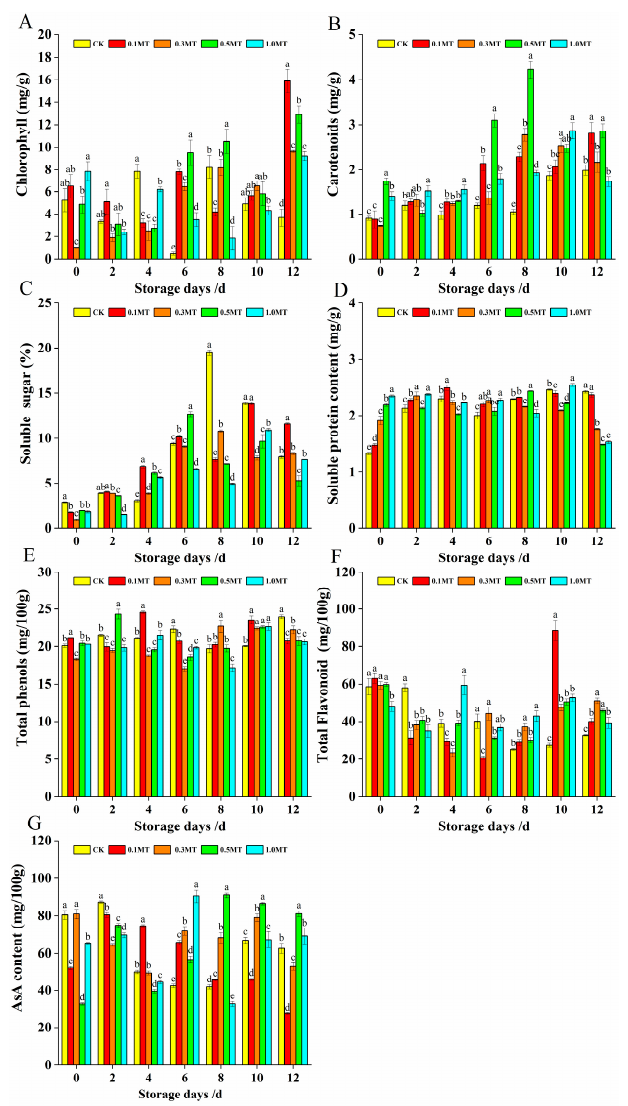
Figure 4. Effect of preharvest melatonin treatment on the nutrient composition of postharvest kiwifruits. ( A ). Chlorophyll ( B ). Carotenoids, ( C ). Soluble sugar ( D ). Soluble protein ( E ). Total phenols ( F ). Total flavonoids, ( G ). Ascorbic acid. Values indicate the means of the replicates; error bars indi- cate the standard deviations of the mean (n = 3). Different lowercase letters indicate significant dif- ferences between treatments ( p < 0.05), while identical letters indicate no significant differences be- tween treatments ( p > 0.05).